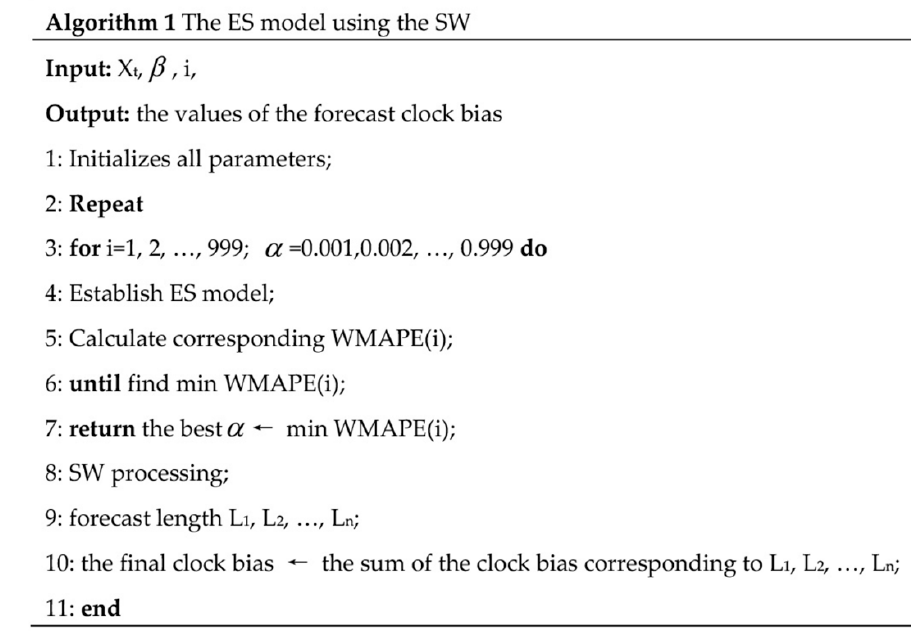
Figure 4. Flow of the ES model using a sliding window.